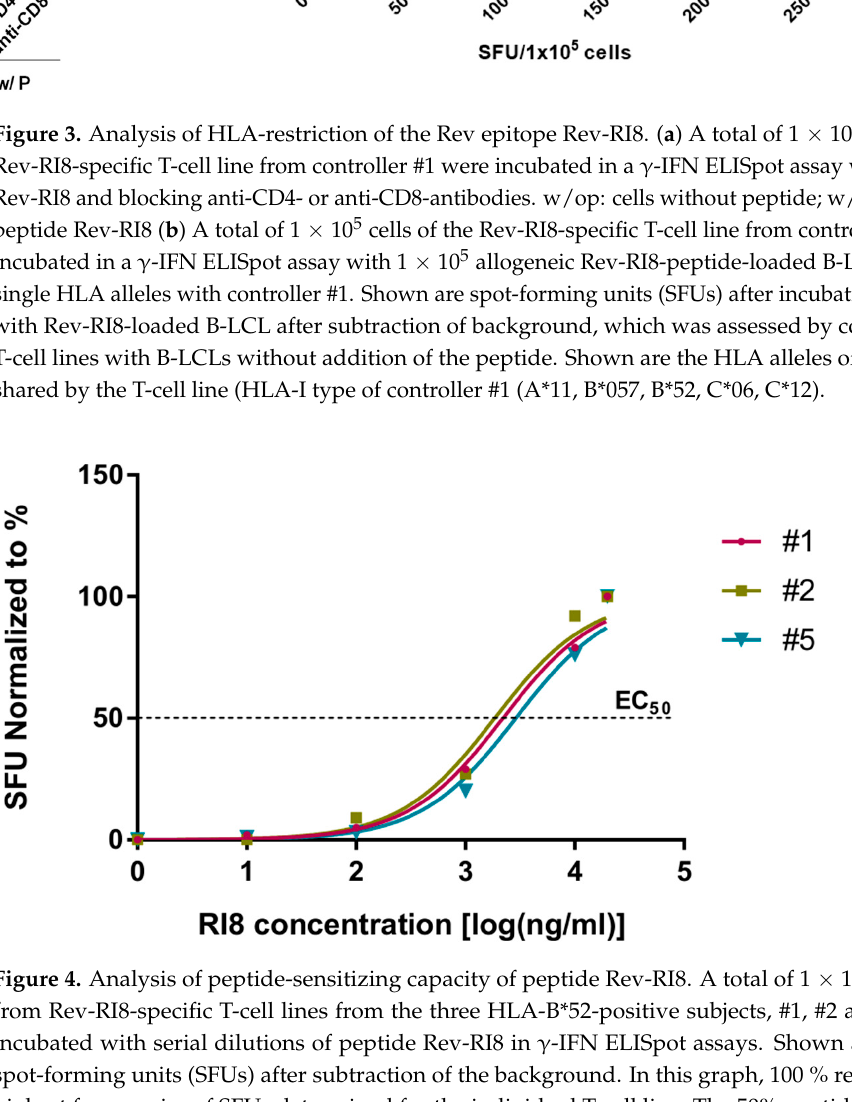
Figure 3. Analysis of HLA-restriction of the Rev epitope Rev-RI8. ( a ) A total of 1 × 10 5 cells of the